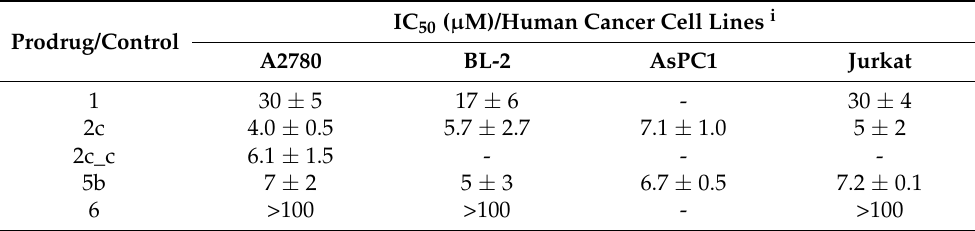
Table 2. Anticancer effects (IC 50 ) of prodrugs and controls towards different human cancer cell lines.